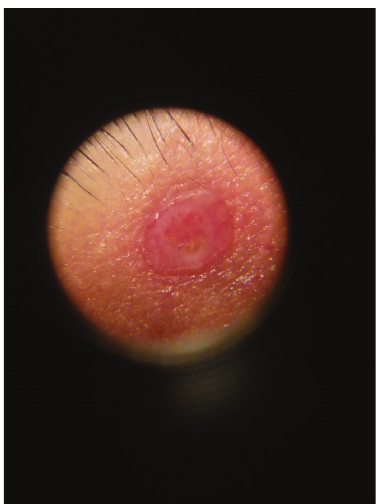
Figure 2: Dermoscopy findings.